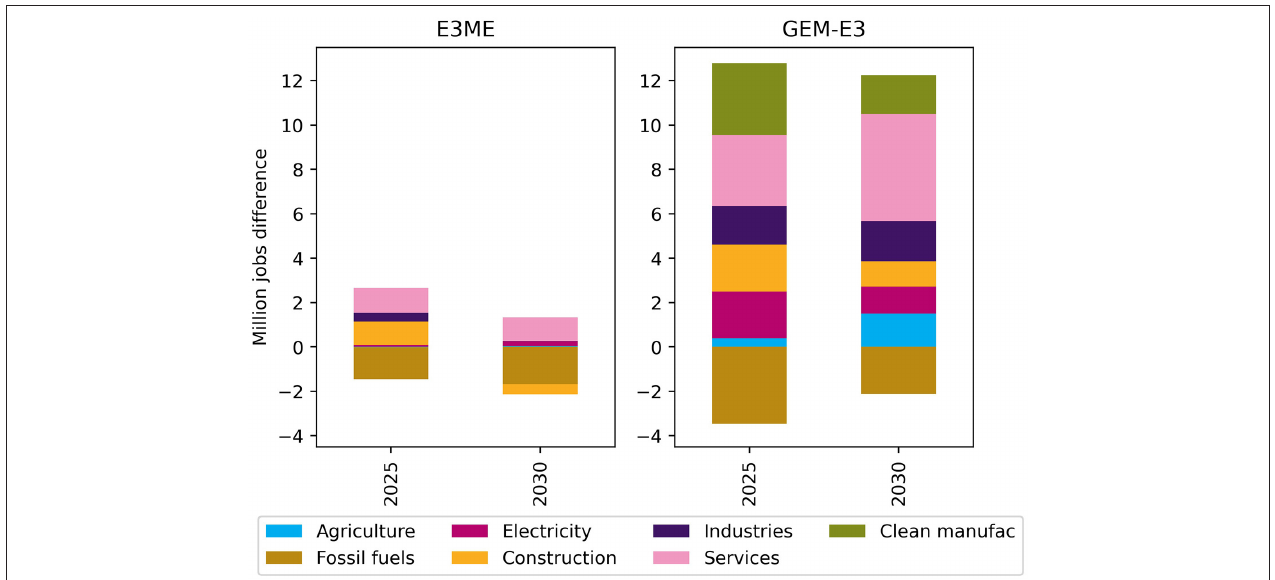
FIGURE 4 | Changes in global employment by sector (in millions) induced by the Green Recovery scenario relative to the COVID scenario (based on E3ME results: left and GEM-E3 results: right).